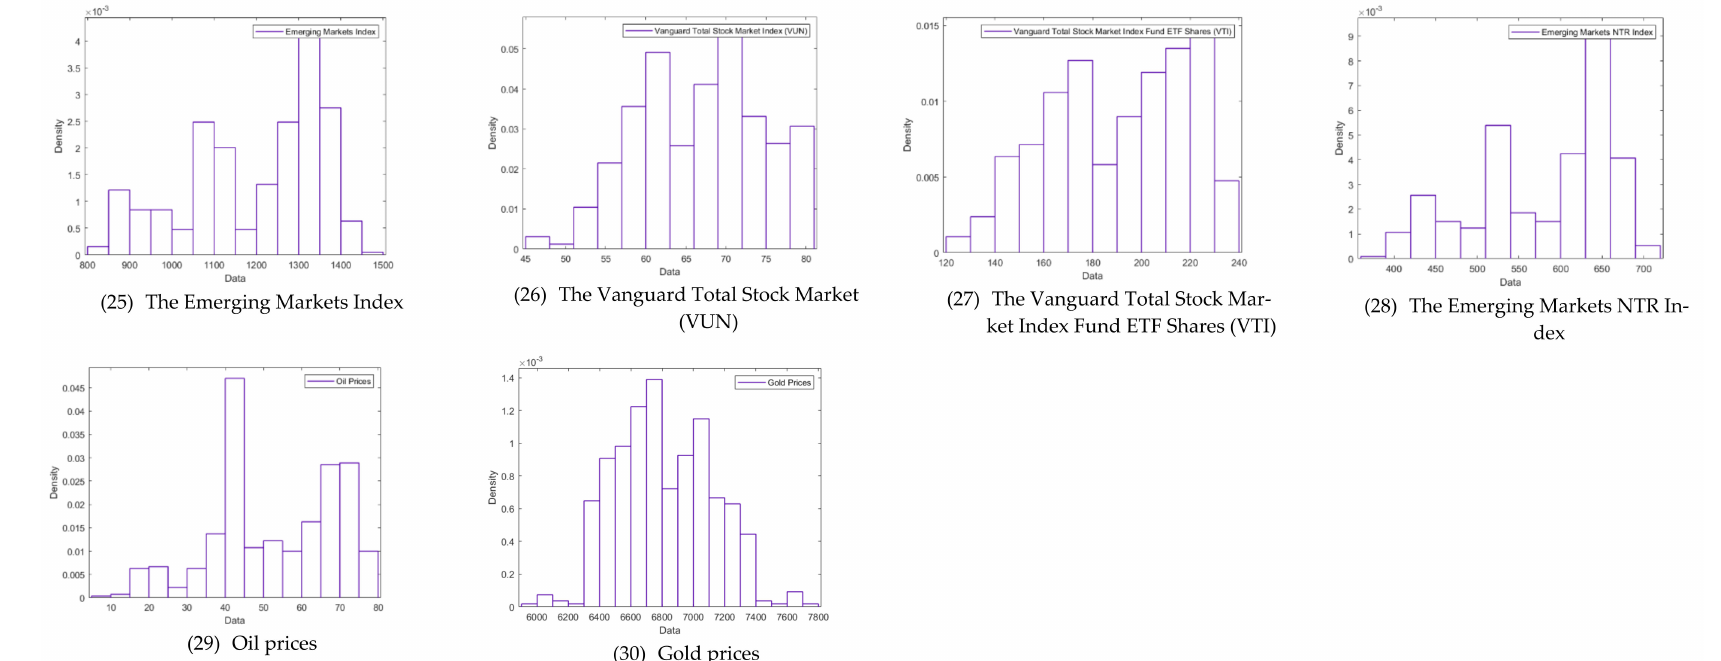
Figure 3. Histograms of varying variables in the integrated